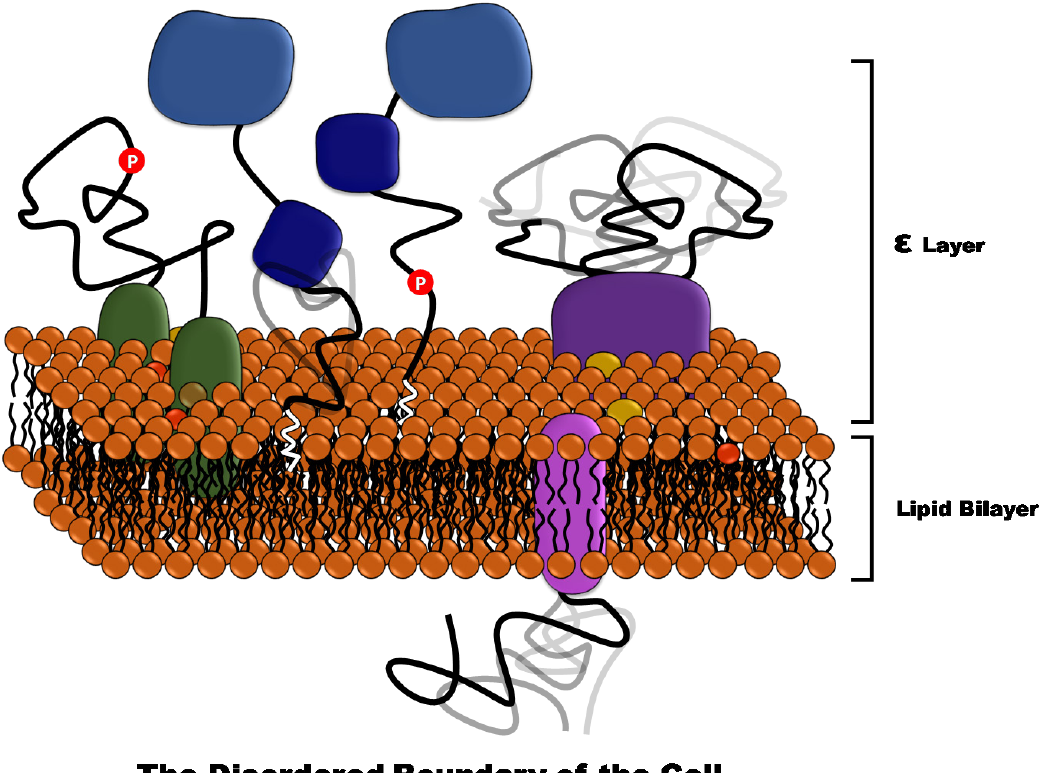
Figure 1: The disordered boundary of the cell. The e-layer is defined as the region occupied by the water soluble IDPs tethered to the membrane surface. Due to the high local concentration of the IDPs, the properties of the e-layer are not just the sum of the features of the individual proteins, in the same way as the properties of the lipid bilayer are not the sum of the features of individual lipids. The coupling between the e-layer and the underlying membrane in the DBC is reminiscent of the coupling between the polar headgroups and the hydrophobic lipid interior. Analogous to the distinct environment provided by the lipids to integral membrane proteins, the e -layer also provides a singular environment for folded domains that are immersed in it, although the nature of the interactions is indeed very different in the hydrophobic core of the membrane and the hydrophilic